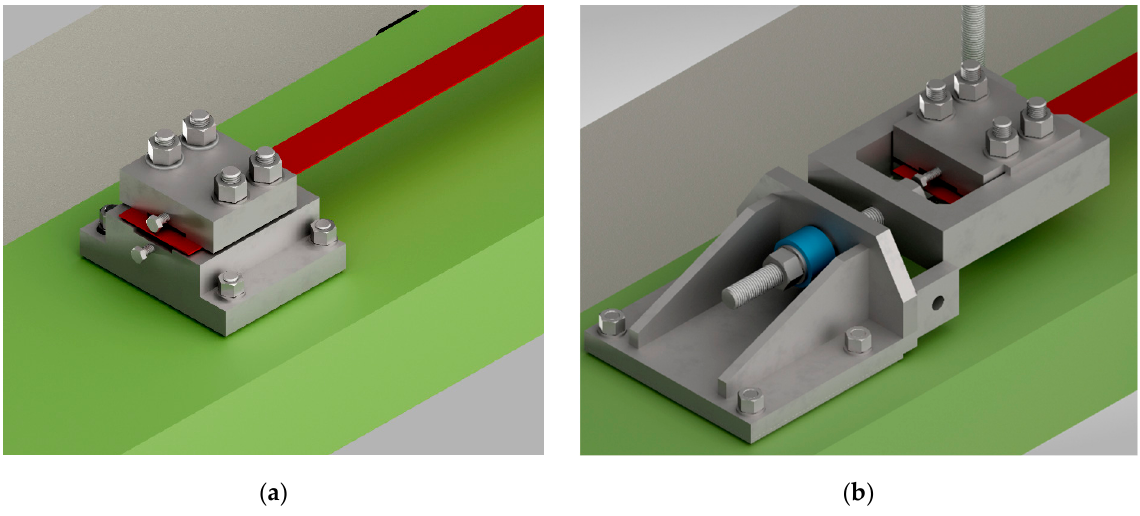
Figure 4. ( a ) SMA strip (red), fix clamping and anchorage device (grey) fixed to the concrete (green), ( b ) clamping and anchorage device (grey) with load cell (blue) to measure the force in the SMA strip.